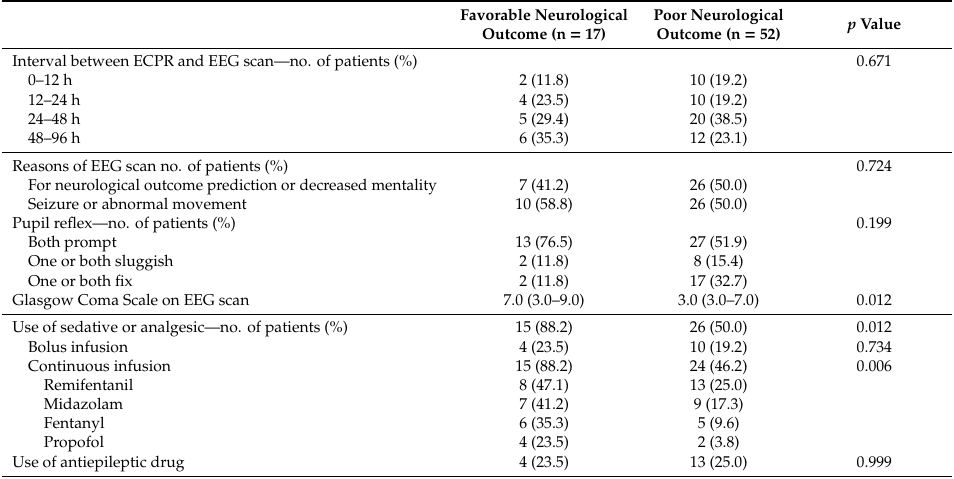
Table 2. Characteristics on electroencephalography scan.